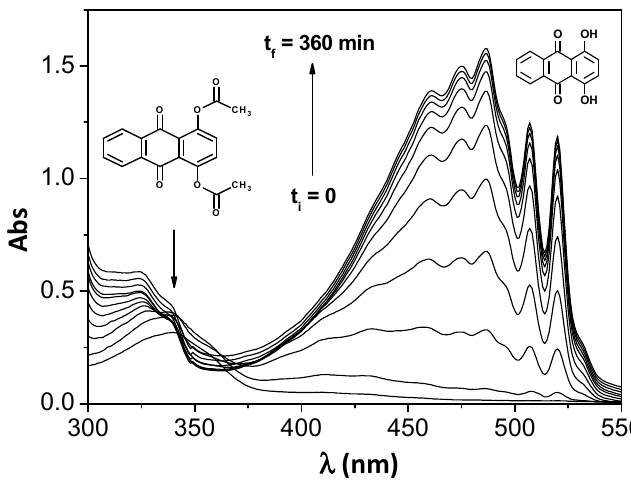
Figure 1. Absorption spectra of quinizarin diacetate (QDA 1.5 × 10 − 4 mol ∙ L − 1 ) conversion to quinizarin (Qz) in water saturated cyclohexane containing 20 mg of Novozym 435, T = 298 K.